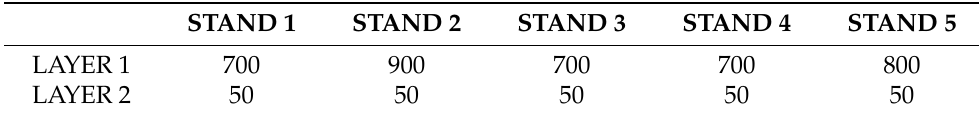
Table 8. The numbers of hidden nodes for each layer for the roll force prediction